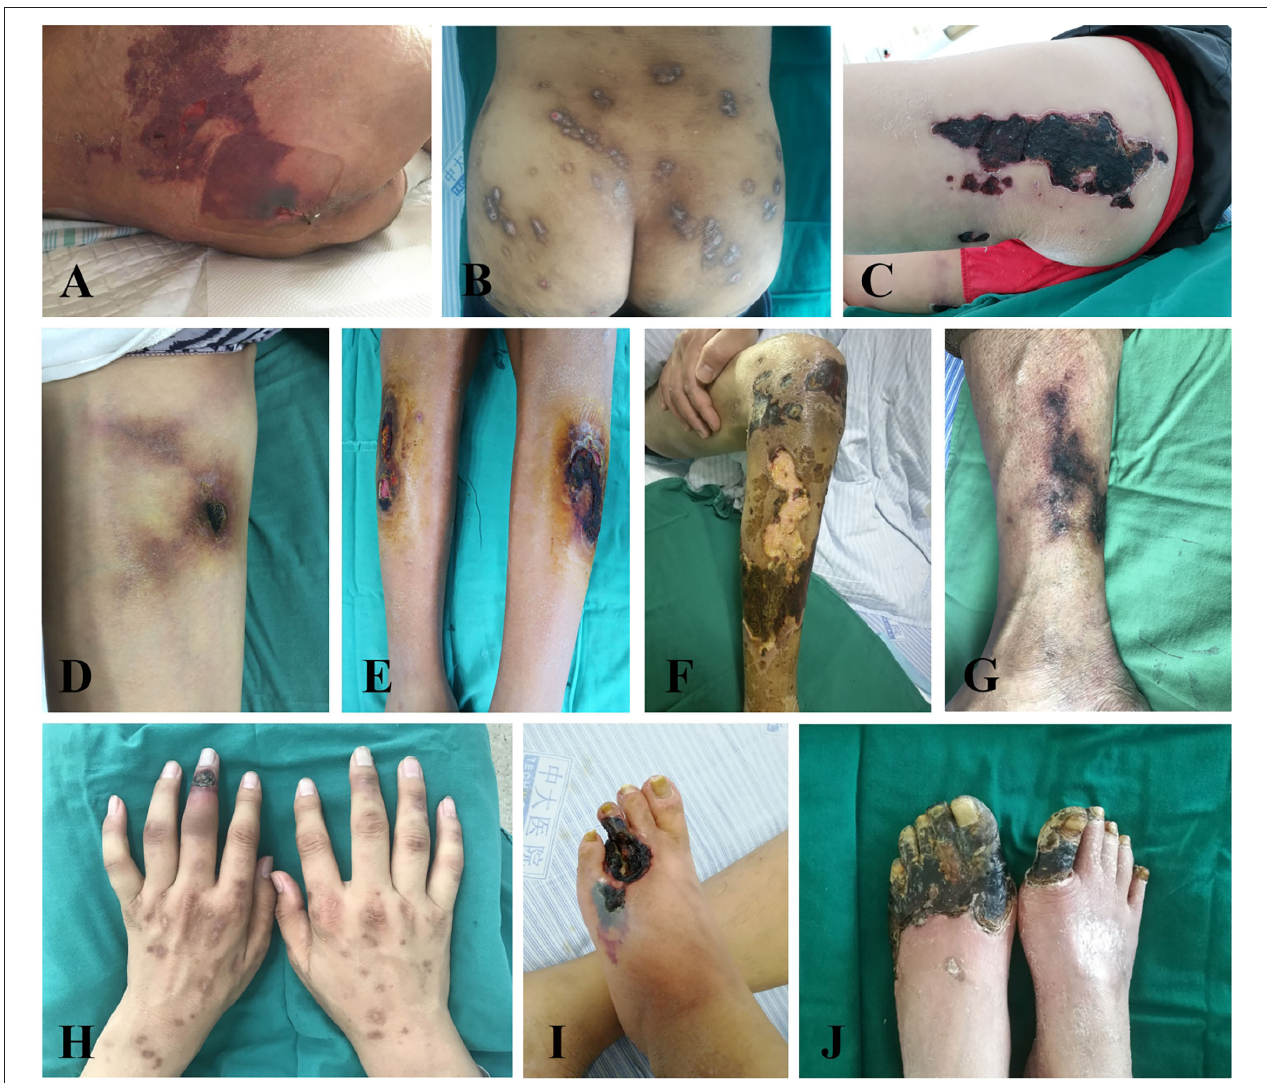
FIGURE 1 | Manifestations of skin lesions with different types of calciphylaxis. According to the affected parts of skin lesions, calciphylaxis can be classified as central and peripheral types. The central calciphylaxis mostly involves fatty central areas such as abdomens, buttocks, and thighs (A–D) , while the peripheral type is limited to peripheral parts with a small amount of adipose tissue, such as hands, feet, and penis (E–J) . Typical skin lesions of calciphylaxis mainly show livedo reticularis, purpura, sclerotic plaques, necrotic ulcers, and black eschar